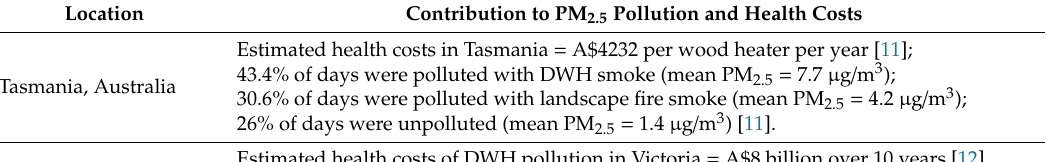
Table 1. Some studies showing domestic wood-heating (DWH) is a major source of particulate matter ≤ 2.5 µ m in aerodynamic diameter (PM 2.5 ) pollution that causes considerable health costs in several countries, states and regional or metropolitan